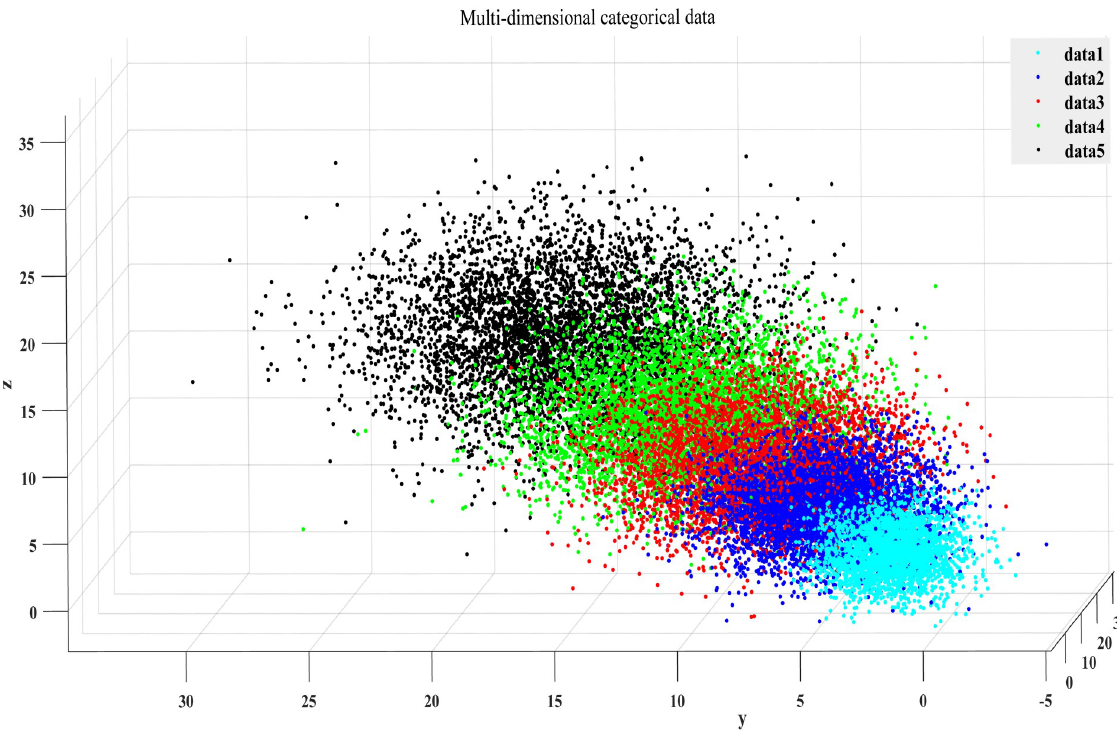
Fig 1. Multi-dimensional classification